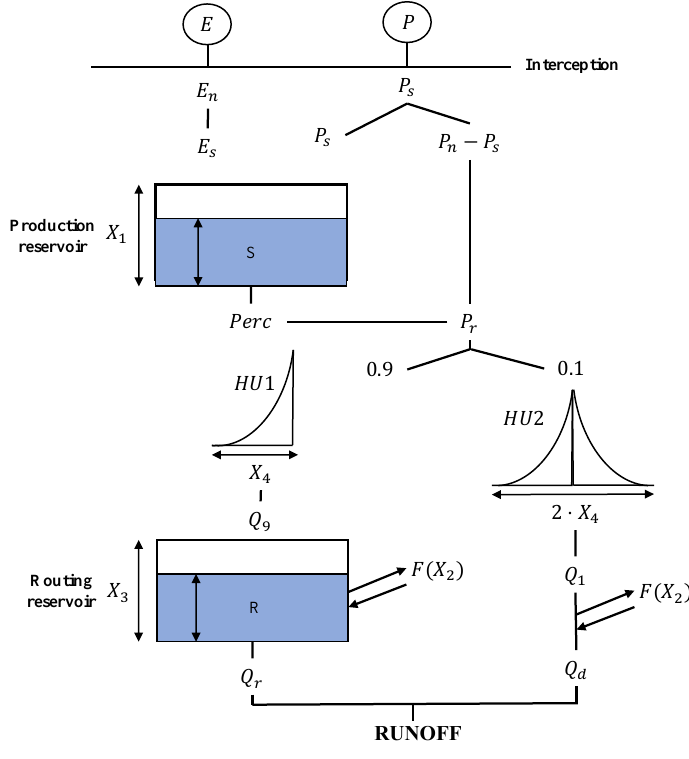
Figure 3. Conceptual diagram of the GR4J